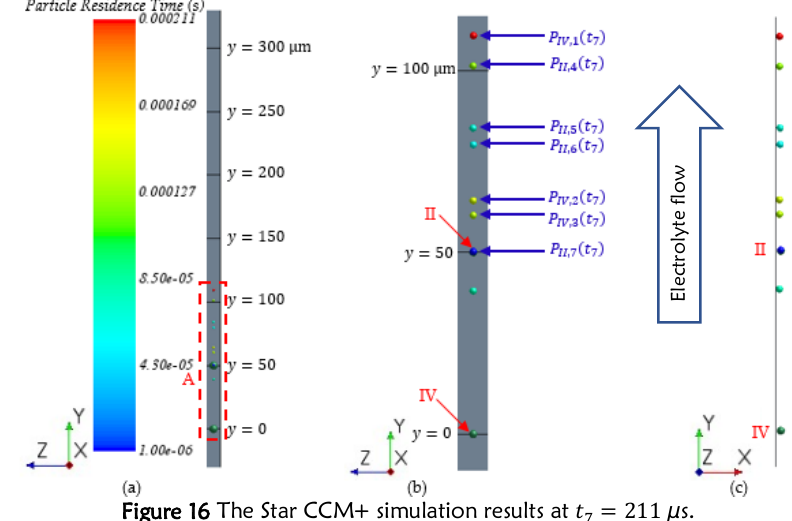
Figure 16 The Star CCM+ simulation results at 𝑡 7 = 211